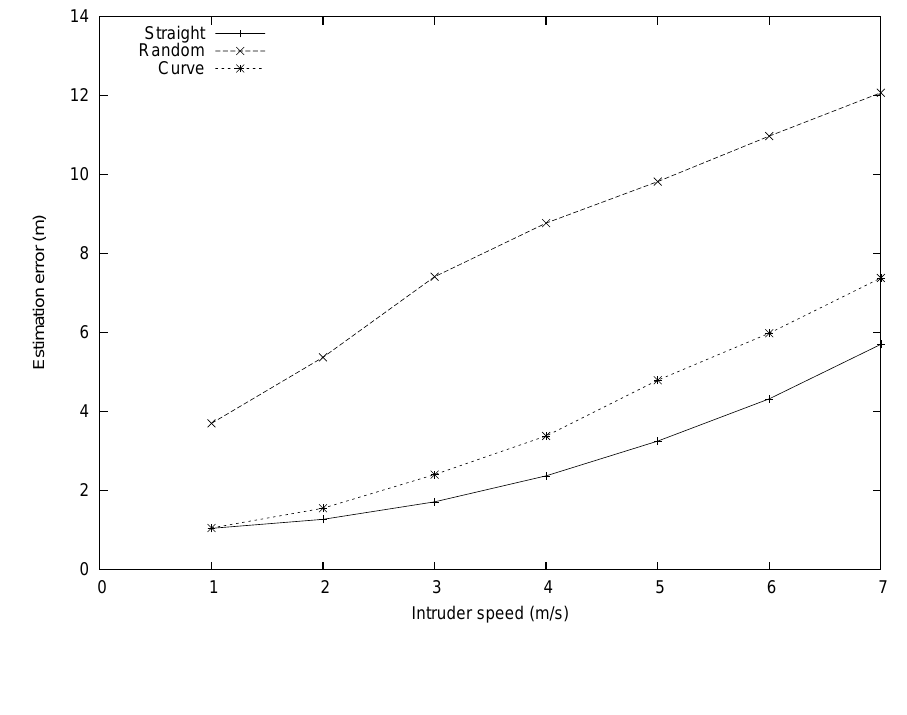
Figure 3. Mean position estimation error for different mobility patterns when varying the intruder